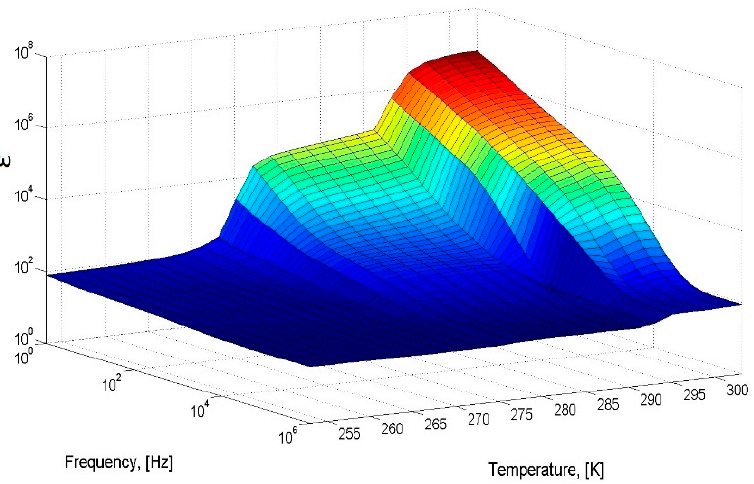
Figure 9. A 3-D diagram of the real part of the dielectric spectrum of the hydrate as the hydrate is heated during the fifth cycle.